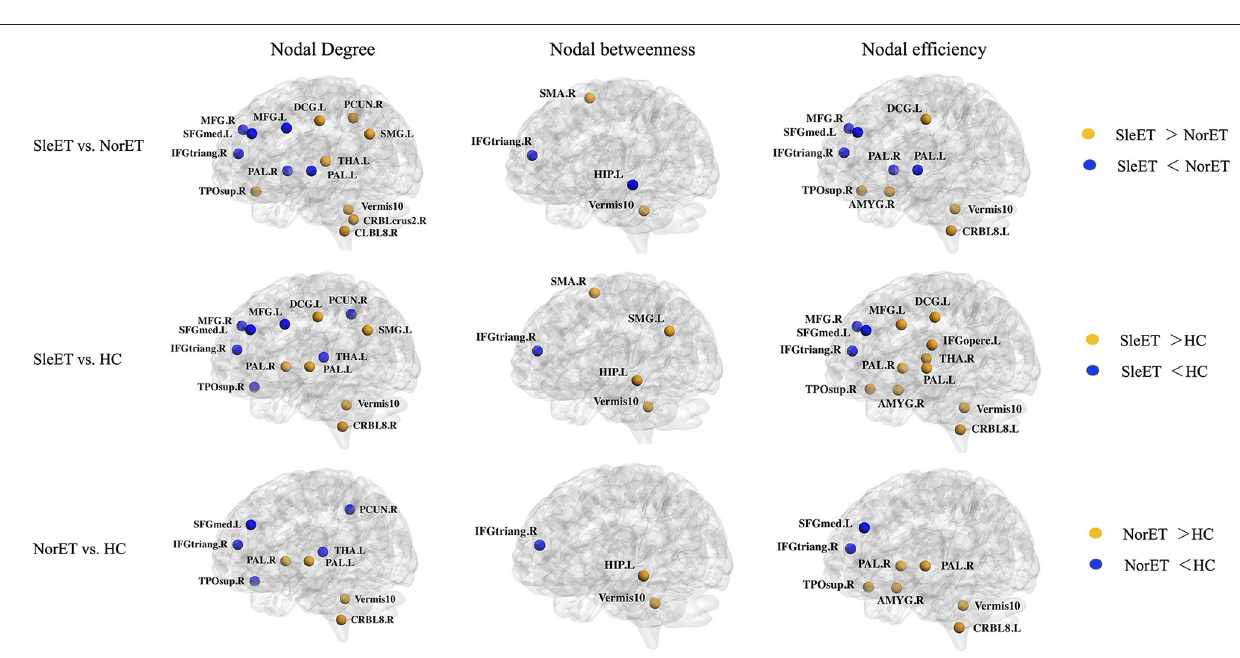
FIGURE 2 | Brain regions with significant group effects in the nodal centralities of morphological brain networks compared among the SleET, NorET, and HC groups. Regions are located according to their centroid stereotaxic coordinates. ET, essential tremor; SleET, ET with poor sleep quality; NorET, ET with normal sleep quality; HC, healthy control; MFG, middle frontal gyrus; IFGtriang, inferior frontal gyrus, triangular part; SFGmed, superior frontal gyrus, medial; SMA, supplementary motor area; PCUN, precuneus; HIP, hippocampus; AMYG, amygdala; DCG, medial cingulate and paracingulate gyri; CAL, calcarine fissure; SMG, supramarginal gyrus; PAL, pallidum; THA, thalamus; CRBL, cerebellum; L, left; R,